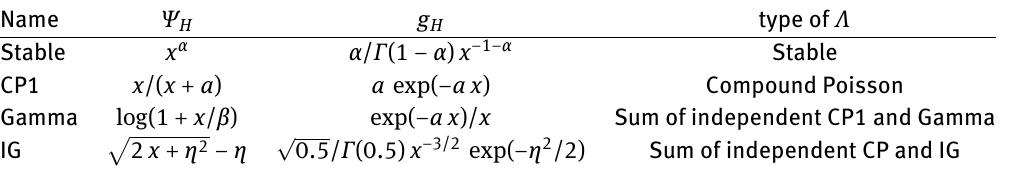
Table 1: Possible choices for Ψ H together with their Lévy densities. One has to add a multiplicative positive factor to adjust for Ψ H (1) = 1 , which is omitted here. The restrictions α ∈ (0, 1), a > 0, β > 0, η > 0 have to hold. All examples are also complete Bernstein functions. For a list of more than one hundred complete Bernstein functions see [39, pp.